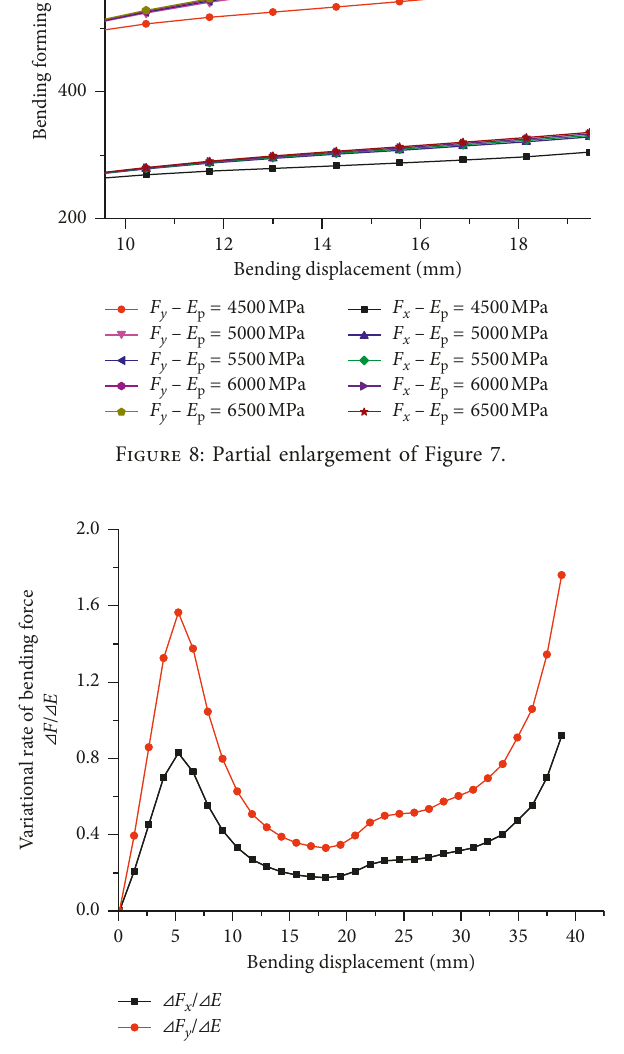
Figure 9: Effect of the rate elastic modulus on the bending load.